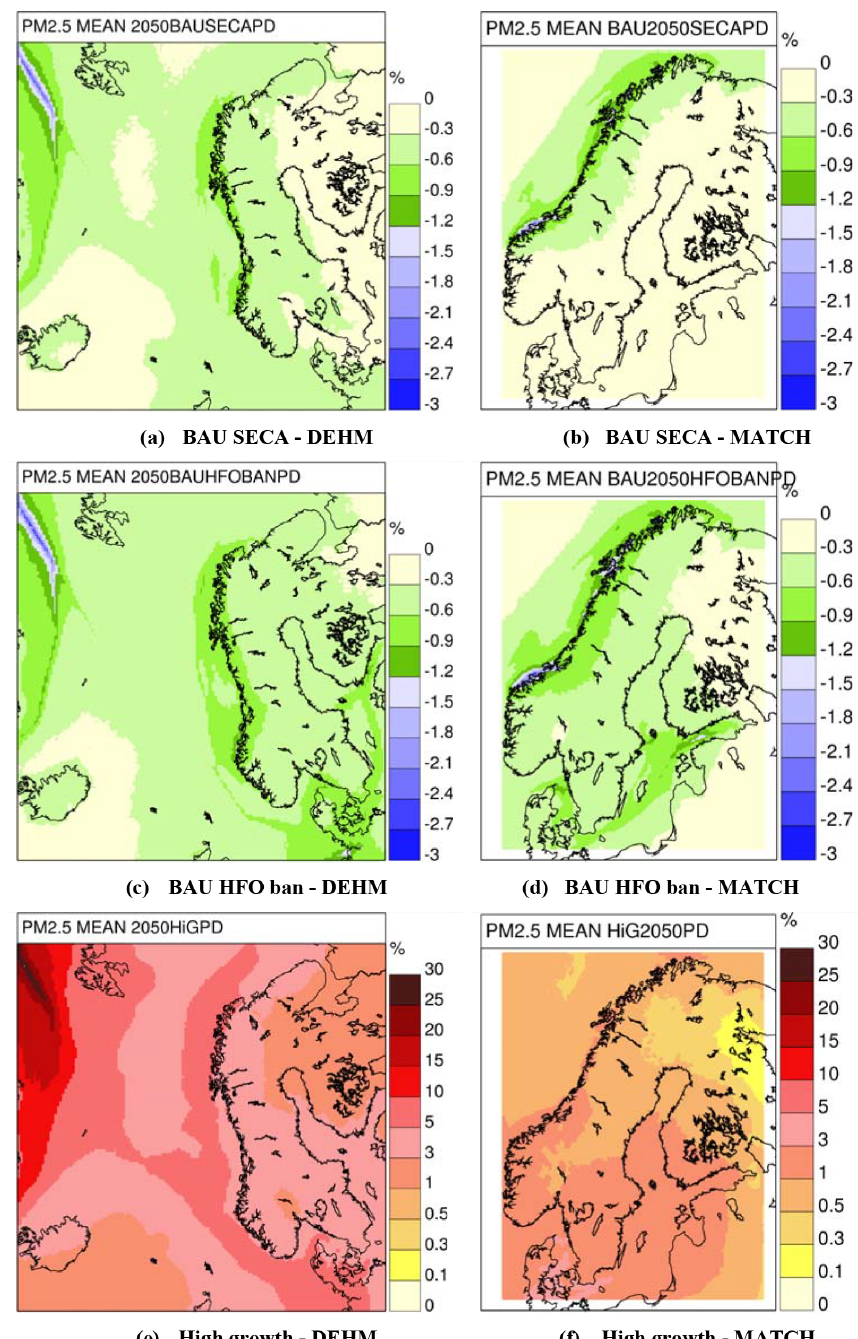
Figure 7. The percentage difference between the BAU Baseline 2050 simulation and the three different ship emission scenarios (in- cluding the polar diversion route) as simulated by the two models DEHM (a, c, e) and MATCH (b, d, f) . Calculated as, e.g. (2050BAU_SECA − 2050BAU) / 2050BAU ·